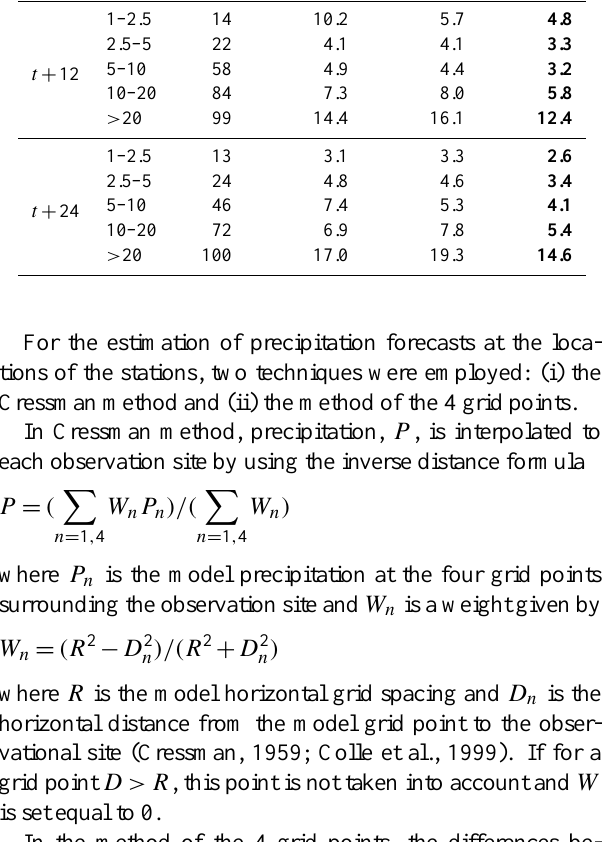
are presented in